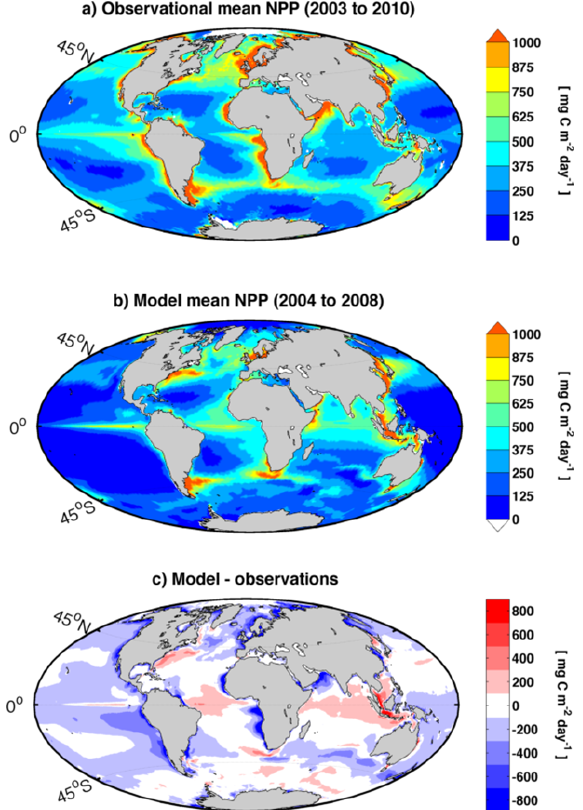
Figure 12. Mean spatial distribution of vertically integrated NPP plotted to the scale used by Schneider et al. (2008). (a) Satellite- based estimate (SeaWIFS, 2012; Behrenfeld and Falkowski, 1997). (b) Model. (c) Residual: modelled − satellite-based